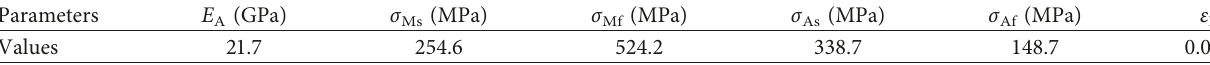
Table 4: Characteristic parameters of simplified model for specimen 14-350-30-MH.